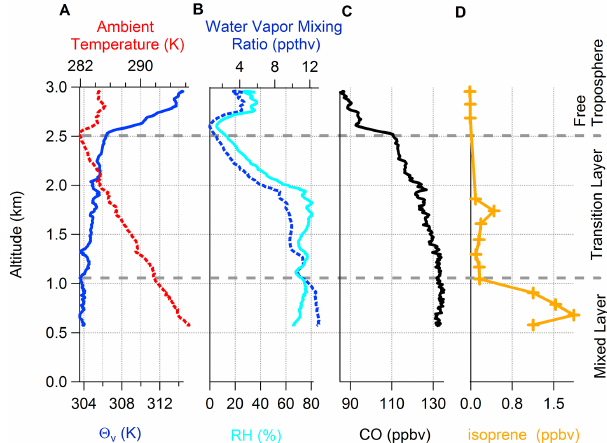
Figure 6. An example profile collected over central Georgia in the afternoon of 16 June showing (a) the temperature and virtual po- tential temperature, (b) the relative humidity and the water vapor mixing ratio, (c) the mixing ratio of CO that has a long lifetime, and (d) the mixing ratio of isoprene that has a short